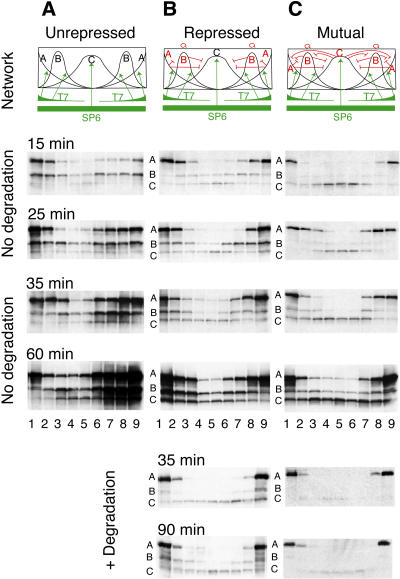
Alternative Gene NetworksAt five set time points (15, 25, 35, 60, and 90 min), transcription-translation chambers were dissected into nine slabs for Western blot analysis.(A) Control network with no repression sites between genes A, B, and C.(B) Minimally repressed network (compare Figure 1).(C) Mutual repression network with extensive negative interactions between species. Adding protease (“+ Degradation”) creates weak but time-stable patterns for both the “Repressed” and “Mutual” networks (35 versus 90 min). Quantitated graphs for the above data are available in Protocol S1.